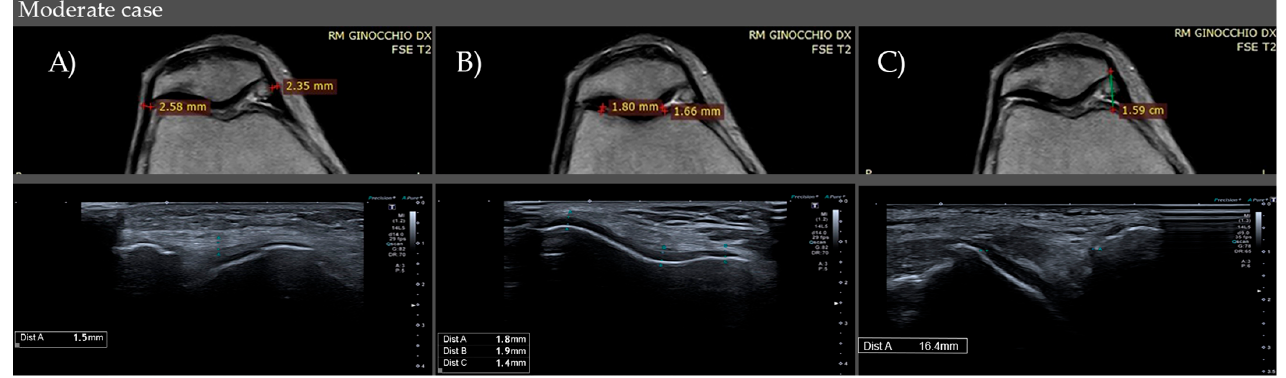
Figure 2. MRI and US values of retinacles ( A ) and cartilage ( B ) thickness and medial patello-femoral distance ( C ). Images of moderate pathological cases.